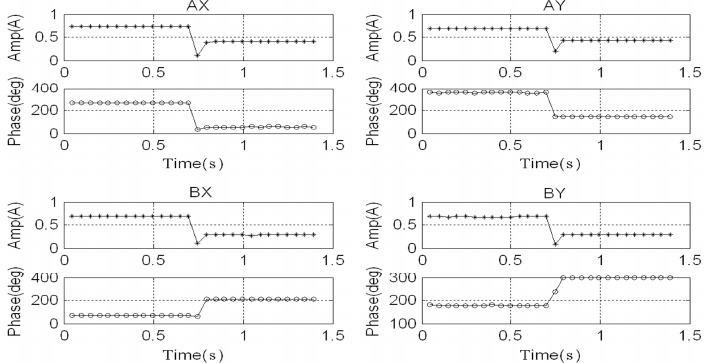
Figure 19. Amplitude and phase of synchronous current before and after adding the GPF.